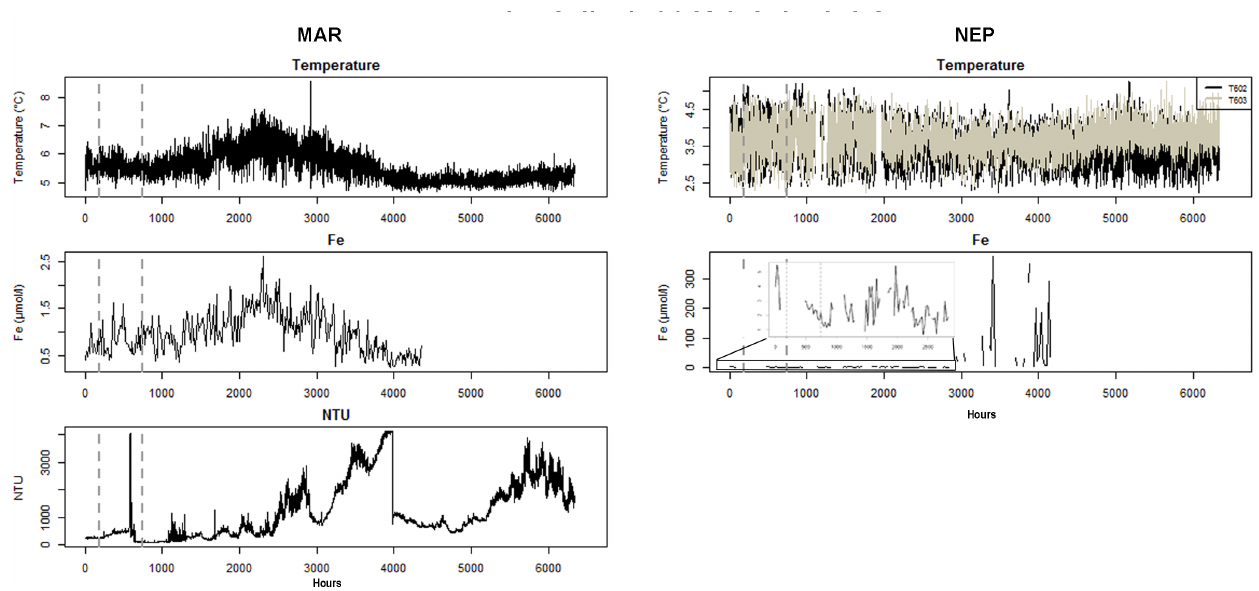
Figure 9. Long-term environmental variable overview. Temperature time series at MAR and NEP represent hourly temperature data spanning 9 months. Fe was recorded over 6 months, twice a day at MAR and daily at NEP. Dotted vertical lines delineate the period for which the images have been analysed. Inset box in Fe graph for NEP shows variation occurring during the first 4 months in more